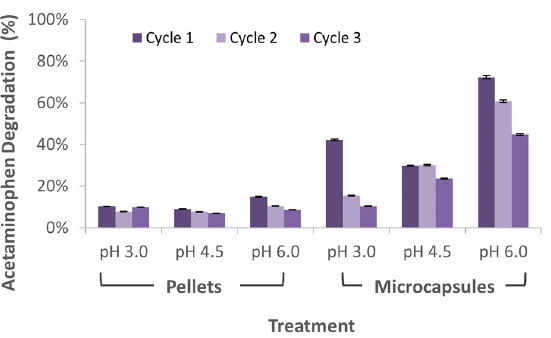
Figure 7. Relative concentration of acetaminophen in the eluded samples of microreactors. Each cycle